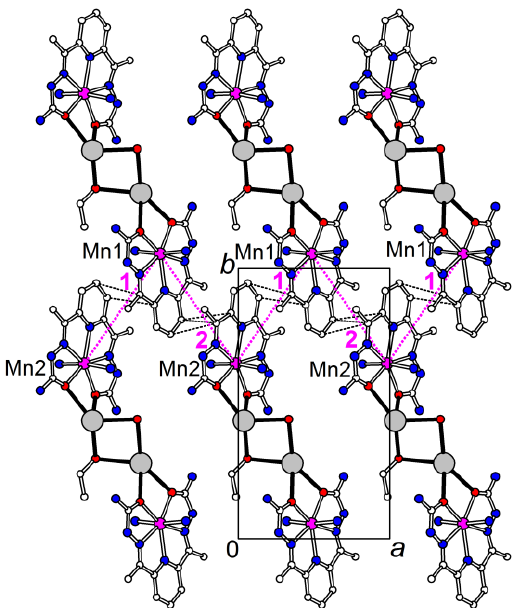
Figure 3. Part of the structure 1 displaying zigzag infinite chain of π -stacked coplanar [Mn(H 2 dapsc)] units; the [Cr(CN) 6 ] anions, H atoms and most of water molecules are omitted for clarity. The Mn-Mn distances are 8.2341(6) and 8.2357(6) Å for 1 and 2 interactions, respectively (magenta dotted lines). Shortened C…C contacts (<3.6 Å) between H 2 dapsc fragments are shown by black dashed lines.